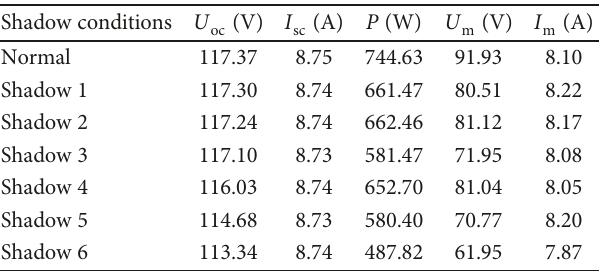
Table 3: Distribution of electrical parameters under shadowing